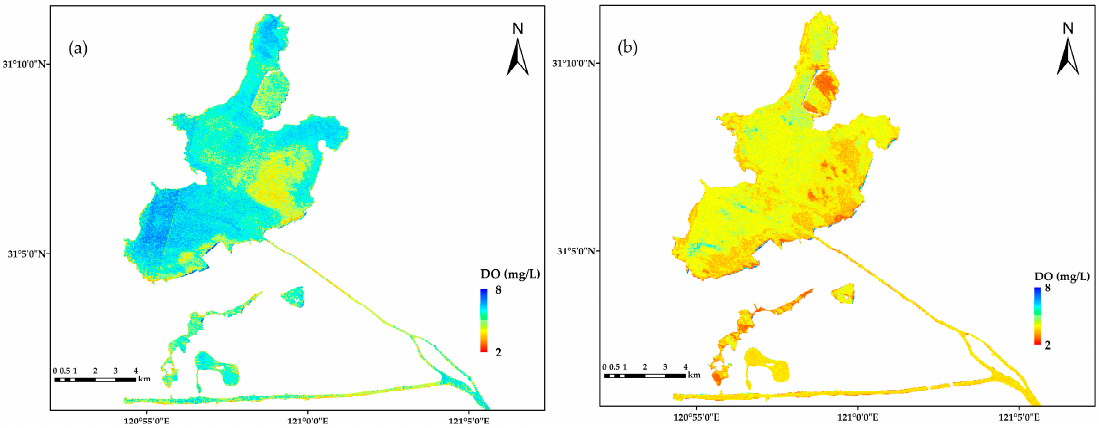
Remote Sens. 2022 , 14 , x FOR PEER REVIEW 12 of 18 Figure 11. Comparison between AHSI 𝑅 (cid:3045)(cid:3046) -derived and in situ DO ( a ), COD Mn ( b ), and TP ( c ).